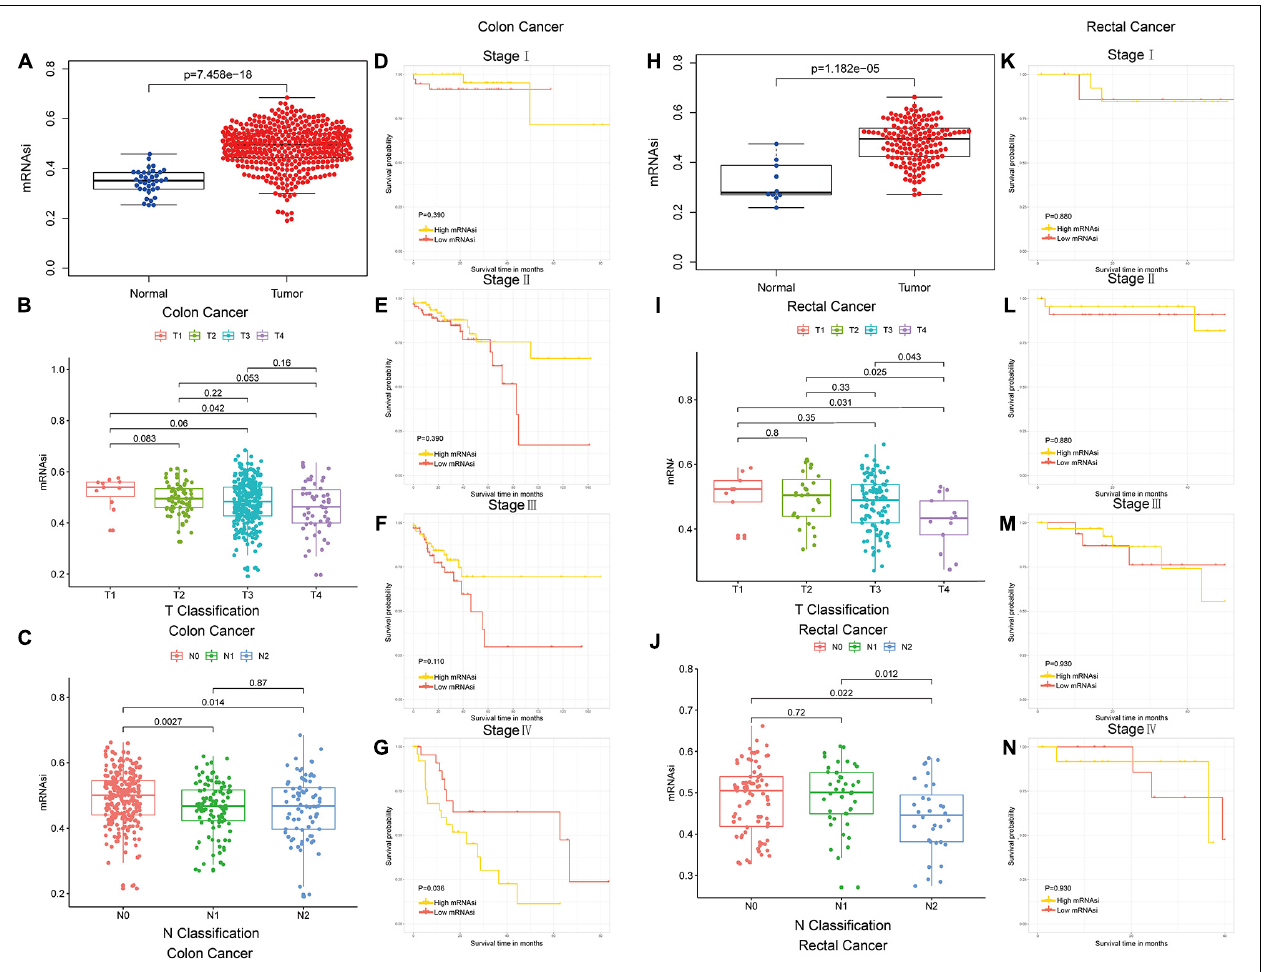
FIGURE 1 | Colon and rectal cancer patients could be subtyped using the mRNAsi. (A) Differences in mRNAsi between normal and colon cancer tissues. (B,C) Comparison of mRNAsi in different T stages (B) or N stages (C) in colon cancer. (D–G) Kaplan–Meier survival curves of mRNAsi in colon cancer. p < 0.05 indicates statistical significance. (H) Differences in mRNAsi between normal and rectal cancer tissues. (I,J) Comparison of mRNAsi in different T stages (I) or N stages (J) in rectal cancer. (K–N) Kaplan–Meier survival curves of mRNAsi in rectal cancer. p < 0.05 indicates statistical